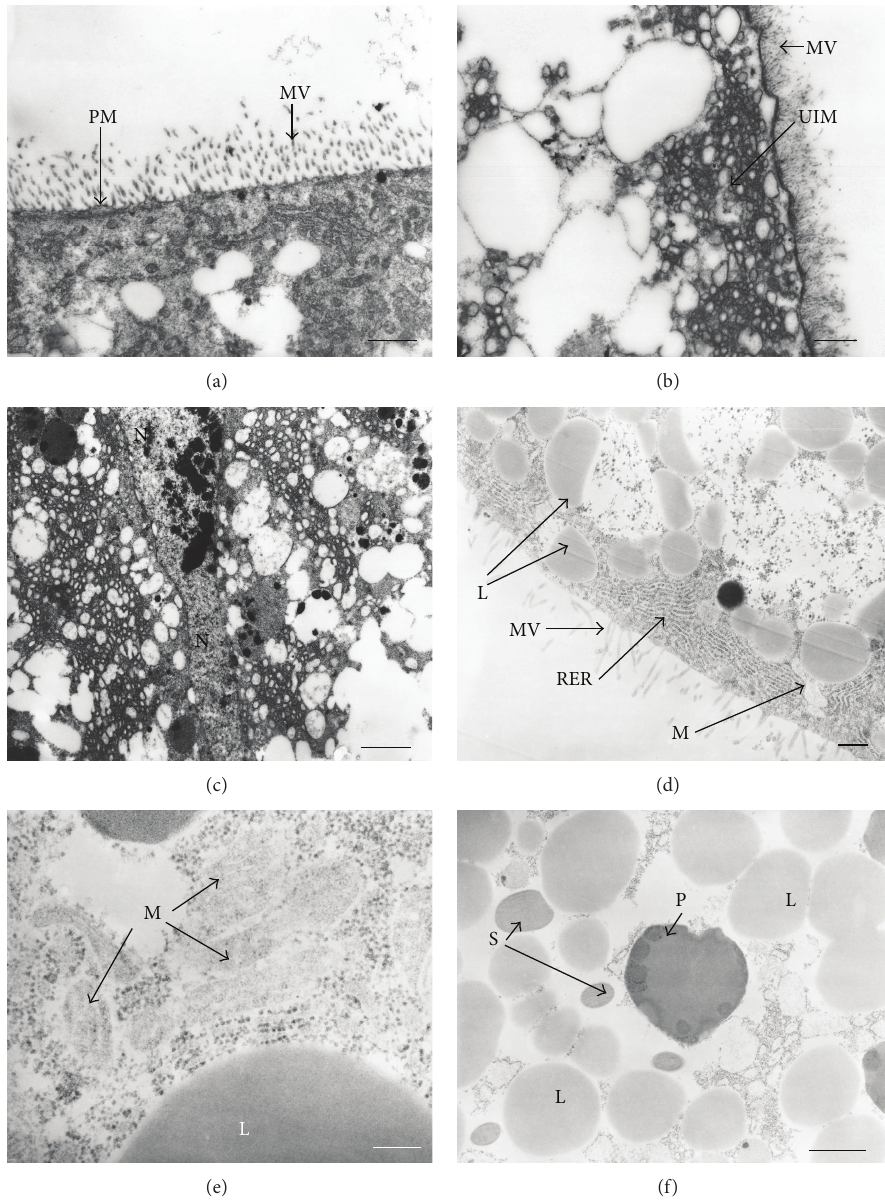
Figure 6: Ultrathin sections of teratocytes were stained with uranyl acetate and Lead citrate. (a) Dense microvilli, rough endoplasmic reticulum, and mitochondria associated with plasma membrane. Scale bar = 500 nm. (b) TEM image of unidentified membranous network located at opposite sides of the teratocyte. Scale bar = 1 𝜇 m. (c) TEM image of one arm of amorphous nucleus showing intense staining of heterochromatin, numerous lipid droplets, and pigment. Scale bar = 1 𝜇 . (d) Same cell showing microvilli, rough ER, and associated mitochondria. Scale bar = 500 nm. (e) Same cell with higher magnification showing mitochondria and lipid droplets. Scale bar = 100nm. (f) Electron micrograph of the internal structure of the same area of the teratocyte showing starch and pigment granules and lipid droplets. Scale bar = 500nm. PM: plasma membrane; MV: microvilli; UIM: unidentified membranous network; N: nucleus; L: lipid droplets; RER: rough endoplasmic reticulum; M: mitochondria; S: starch; P: pigment granules. Scale bar = 20 𝜇